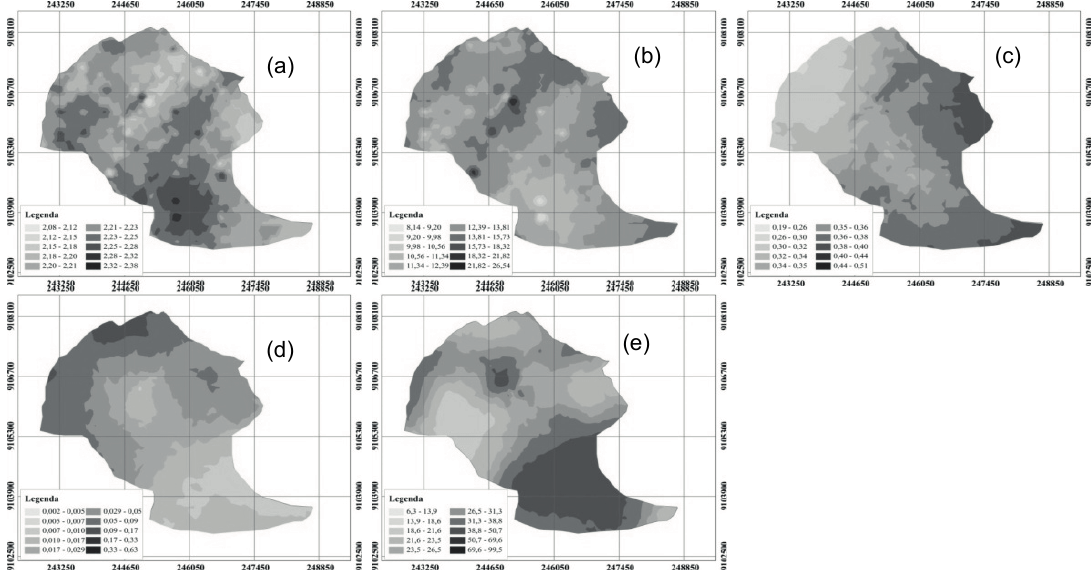
Fig. 4 Spatial distribution maps of the studied parameters in Gameleira basin (Tapacurá sub basin): (a) and (b) are shape parameters n and η, respectively, and ( c), (d) and (e ) are standardization parameters, θ s , K s and h g